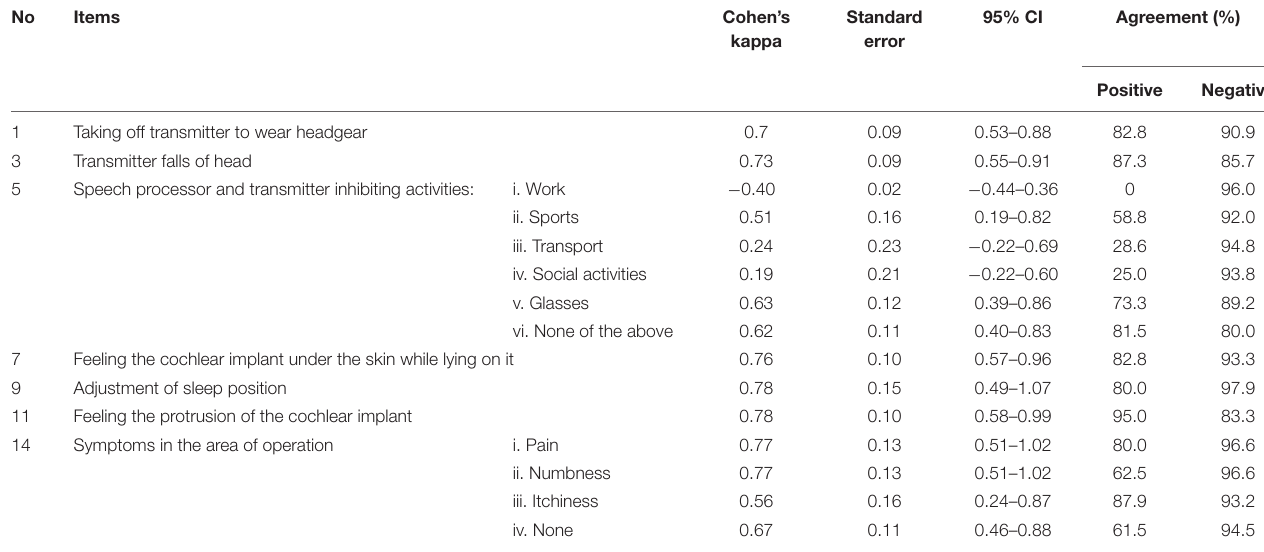
TABLE 4 | Reliability and measurement error analysis for checkbox and multiple choice items (nominal